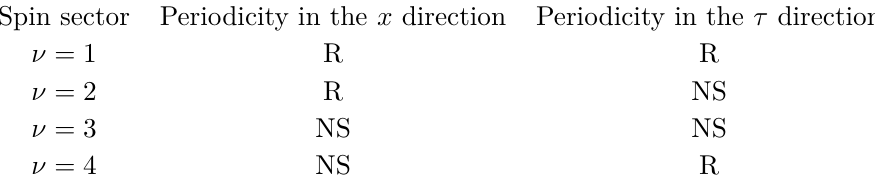
Table 1 . Boundary conditions along the torus corresponding to the 4 sectors ν ’s. NS and R stand for Neveu-Schwarz or Ramond periodic condition,